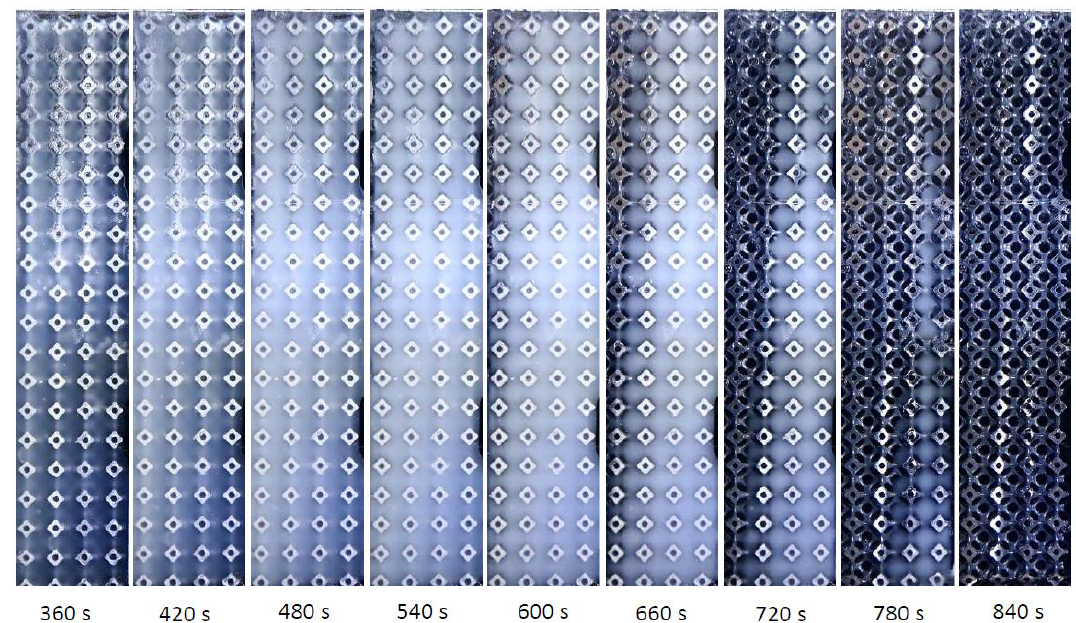
Figure 5. Temperature profiles for the paraffin RT42 with an imposed heat flux of 10 kW m − 2 .